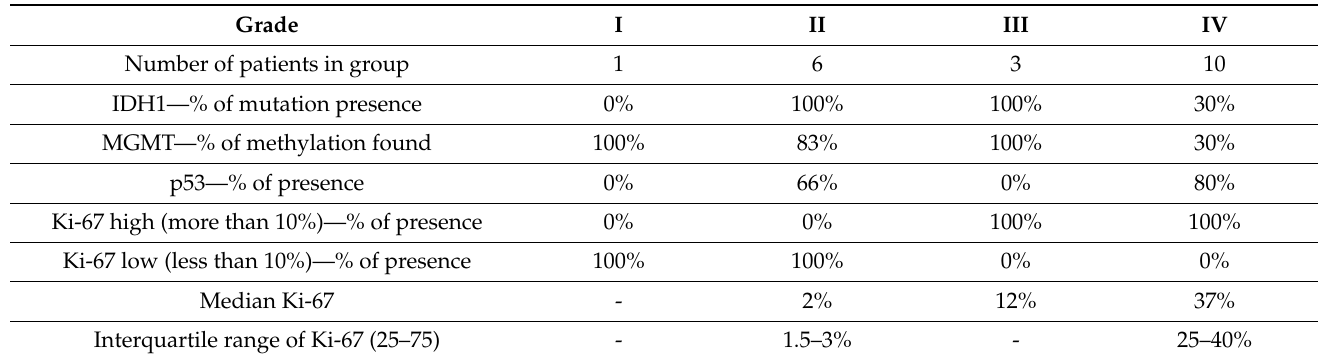
Table 1. Morphometric estimation of tumor markers in glioma tissue with varying degrees of anaplasia in 20